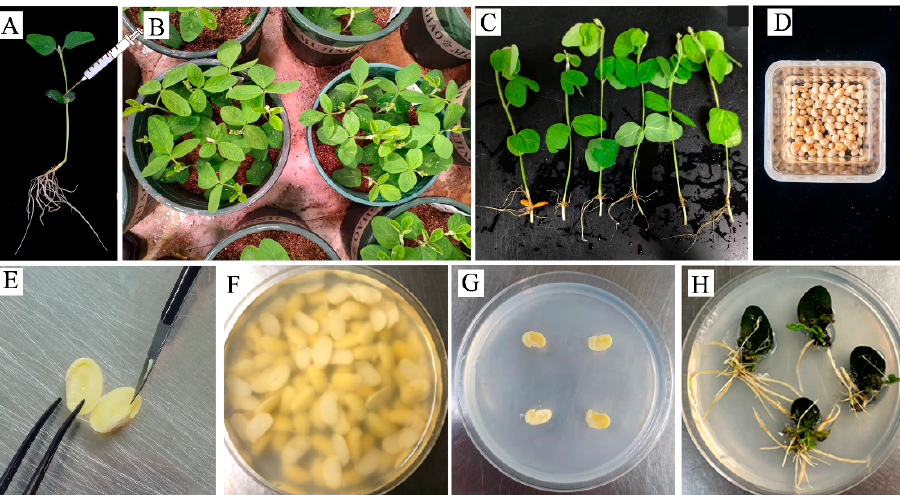
Figure 1. Procedures of soybean hairy root transformation using one-week-old seedlings or imbibed seeds as explants. ( A – C ) Procedure of in planta A. rhizogenes -mediated hairy root transformation using one-week-old seedlings as explants. ( A ) Soybean seeds were plants in vermiculite soil pots for one week prior to inoculation. ( B ) Inoculation of A. rhizogenes by stabbing of hypocotyls adjacent to cotyledonary nodes. ( C ) Induction of hairy roots 2 weeks post-inoculation (DPI). ( D – H ) Procedure of A. rhizogenes -mediated hairy root transformation using imbibed seedlings as explants and adding a select agent in root induction medium ( D ) Overnight imbibed seeds as explants. ( E ) Preparation of half-seed explants. ( F ) Inoculation of A. rhizogenes . ( G ) Explants in the root inducing (RI) medium. ( H ) Induced hairy roots at 14 days post-infection.